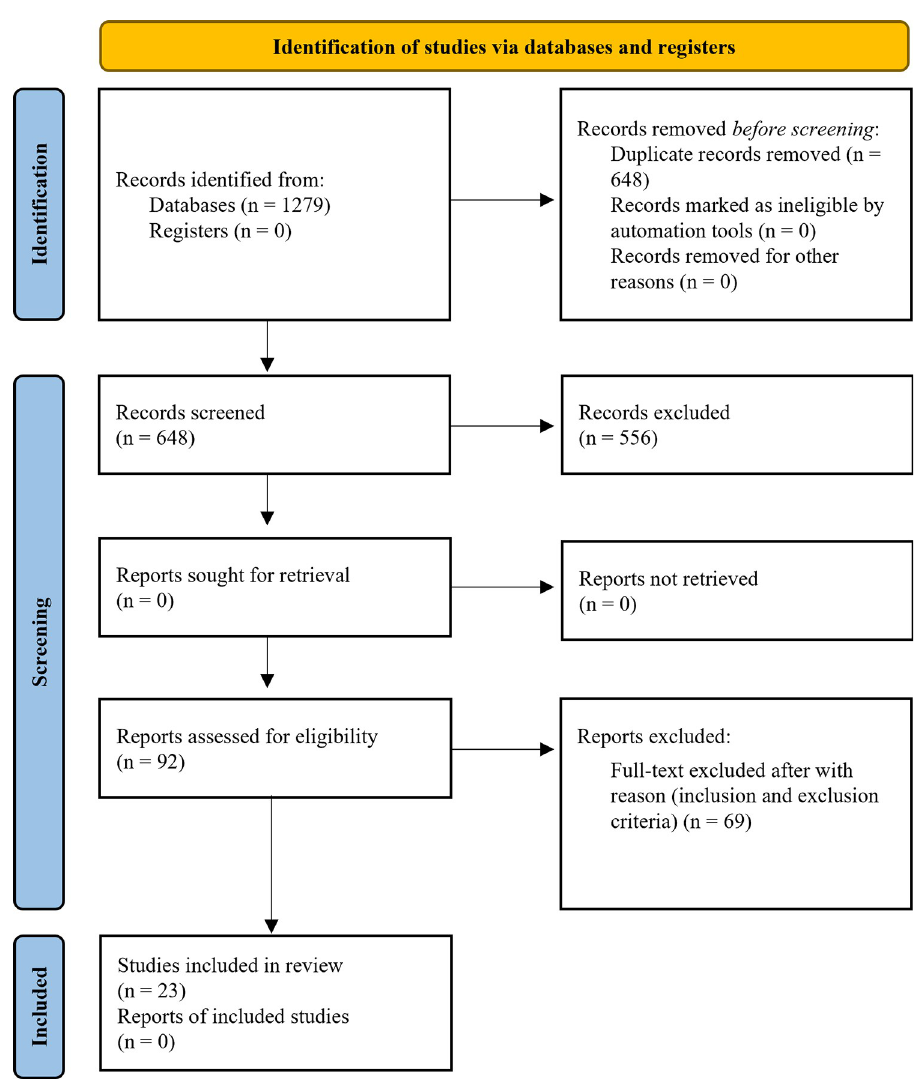
Fig 1. PRISMA flow diagram of the studies’ selection. Figure based on https://prisma-statement.org/ prismastatement/flowdiagram.aspx [5].